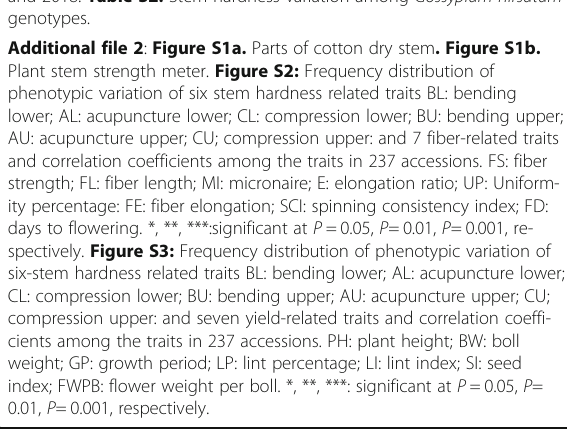
Additional file 1 : Table S1. Descriptive statistics of 20 traits in 2017 and 2018. Table S2. Stem hardness variation among Gossypium hirsutum